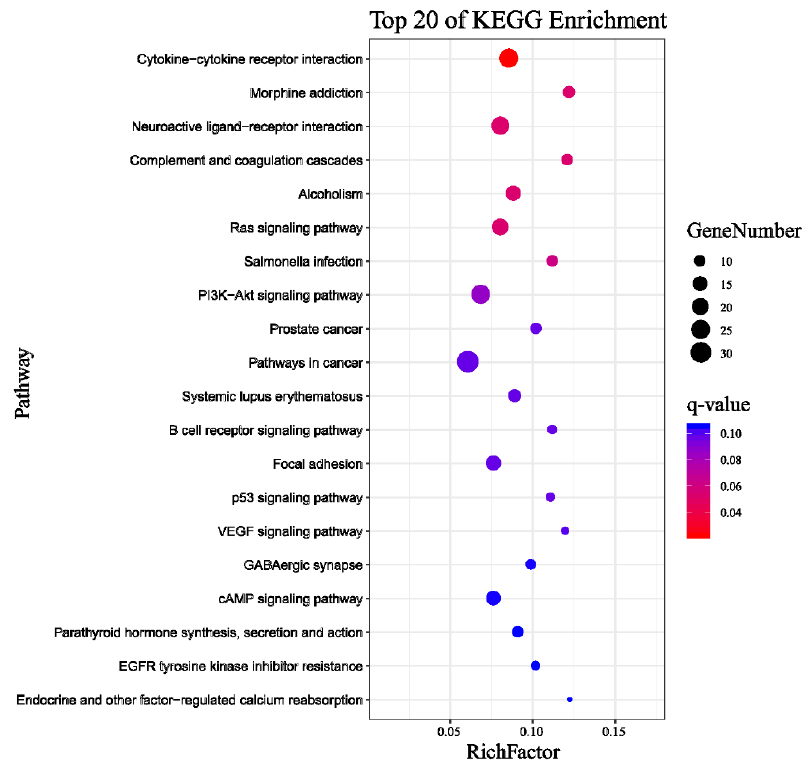
Figure 7. Top 20 pathways of KEGG terms for 681 DEGs. GeneNumber: number of target genes in a pathway. RichFactor: ratio of number of target genes divided by number of all the genes in a term or pathway.